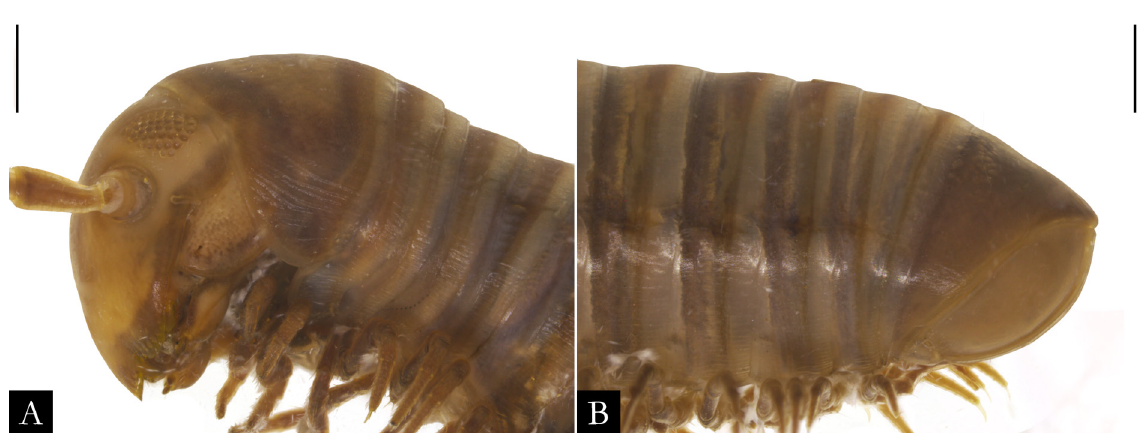
Fig. 76. Pseudonannolene leopoldoi Iniesta & Ferreira, 2014, paratype, ♂ (ISLA 4127), in lateral view. A . Anterior region. B . Posterior region. Scale bars = 1